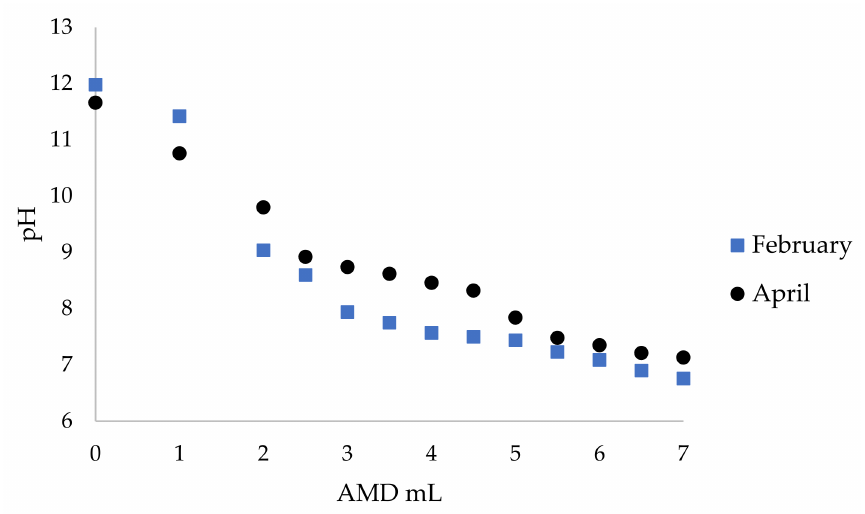
Figure 6. Titration of flotation wastewater with acid mine drainage from the adit collected in February and